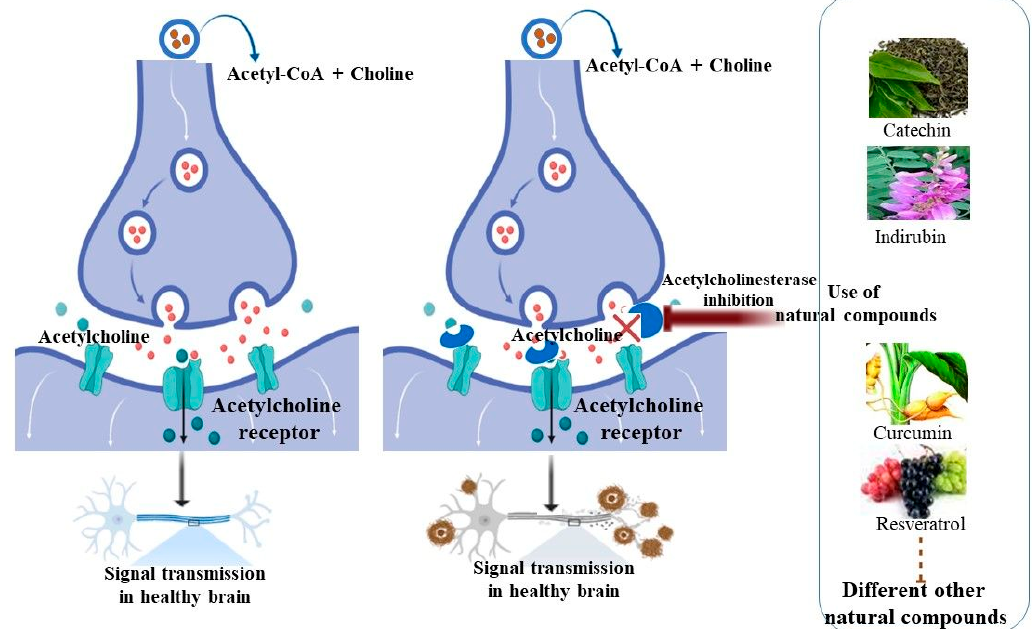
Figure 1. The inhibition process of AChE using natural compounds. AChE inhibitors such as natural compounds bind to the AChE enzyme and prevent the breaking down of ACh, causing ACh to accumulate in nerve synapses and impair neurotransmission.